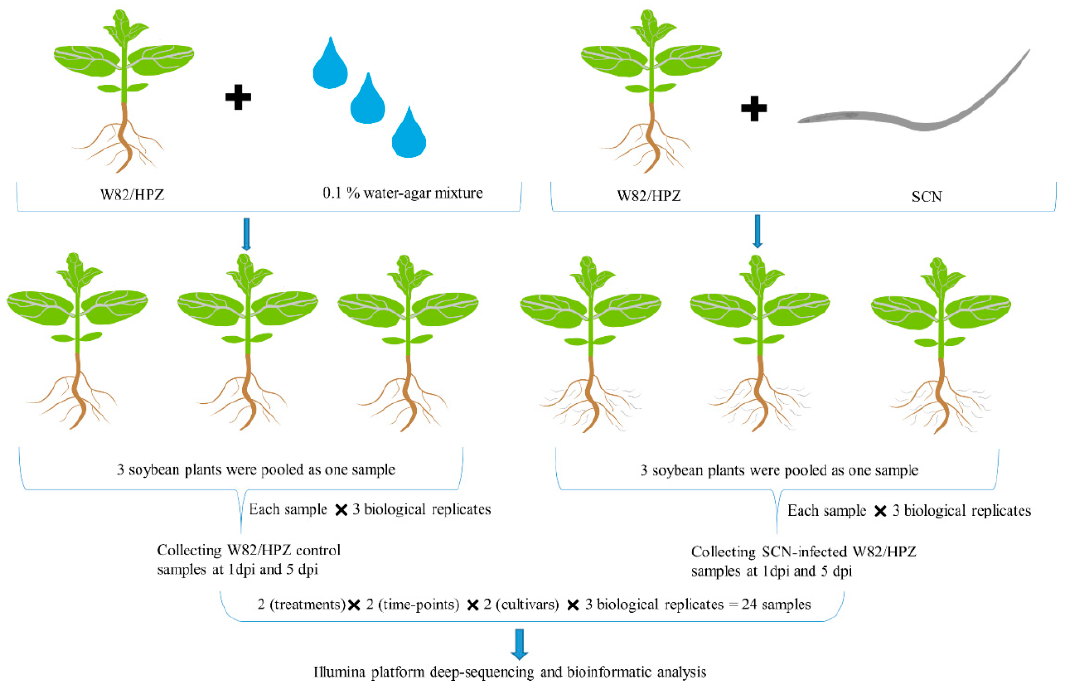
Figure 3. The workflow of the construction of 24 small libraries. In total, 1 mL 0.1% water-agar mixture containing approximately 2000 SCN J2s (second stage juveniles) or water-agar mixture alone as the treatment or control, respectively, were added to the root system of soybean seedlings. Three soybean seedlings were pooled as one sample, each sample contained three biological replicates, and these samples were collected at 1 and 5 dpi, respectively. In total, 24 samples used for small RNA libraries construction were prepared, namely, 24 samples = 2 (treatments) × 2 (time-points) × 2 (cultivars) × 3 (biological